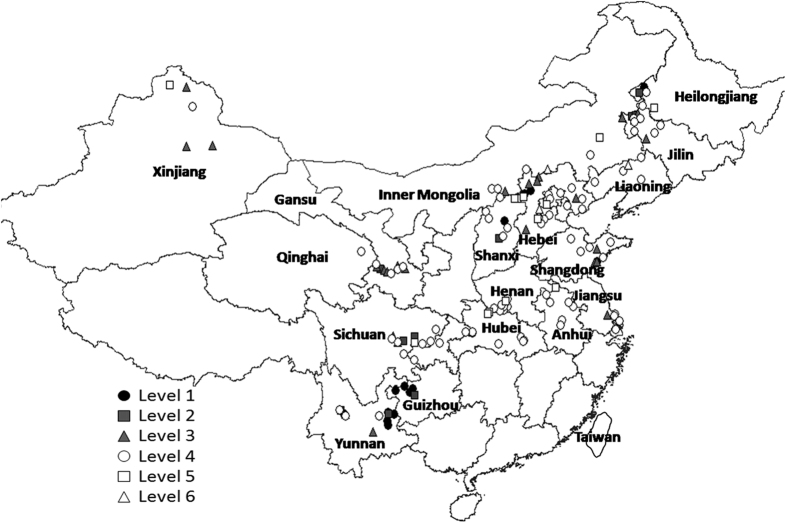
Map of classification of soil organic matter (SOM) in food legumes growing areas, Greater China.Created by DIVA_GIS (v7.5) software. Hijmans, R.J., Guarino, L., Mathur P. DIVA-GIS. Version. 7.5. http://www.diva-gis.org/ (2012) Data of access: 05/07/2015.